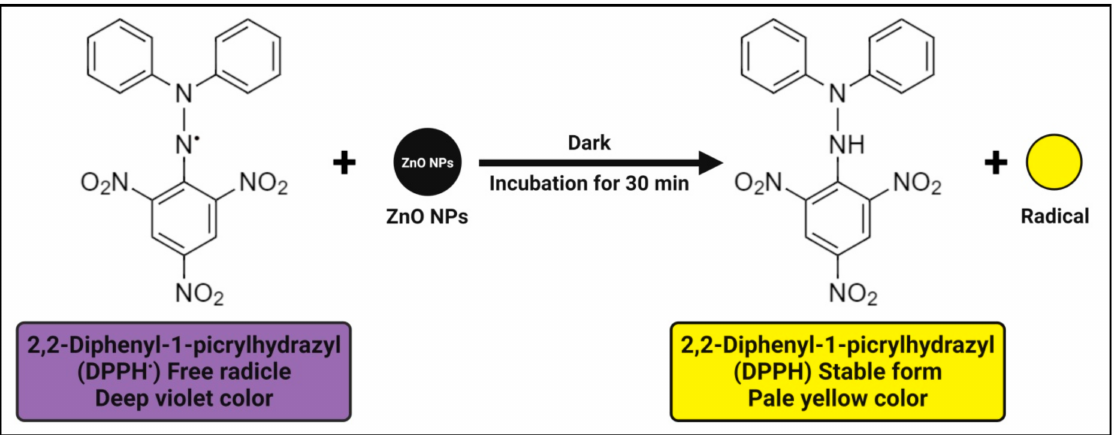
Figure 3. Possible antioxidant mechanisms of plant-mediated zinc oxide